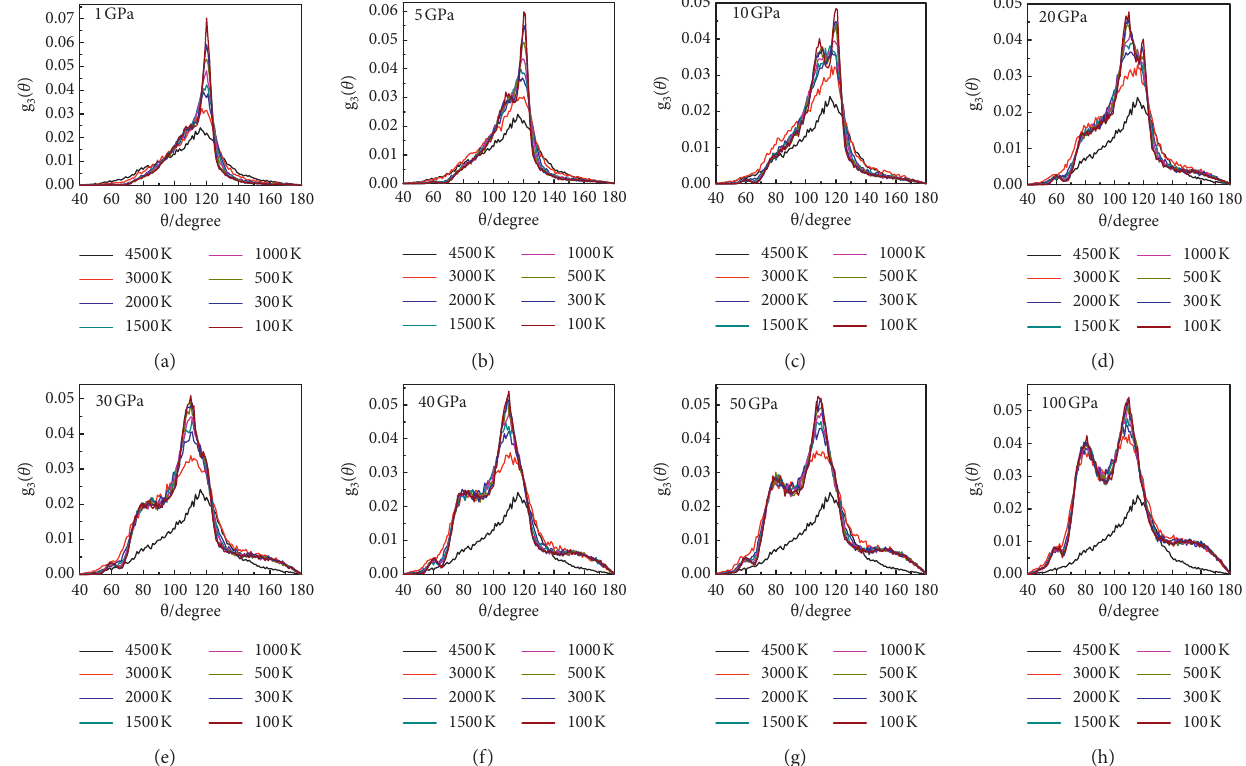
Figure 6: Change in BADF of SiC with temperature under different pressures.